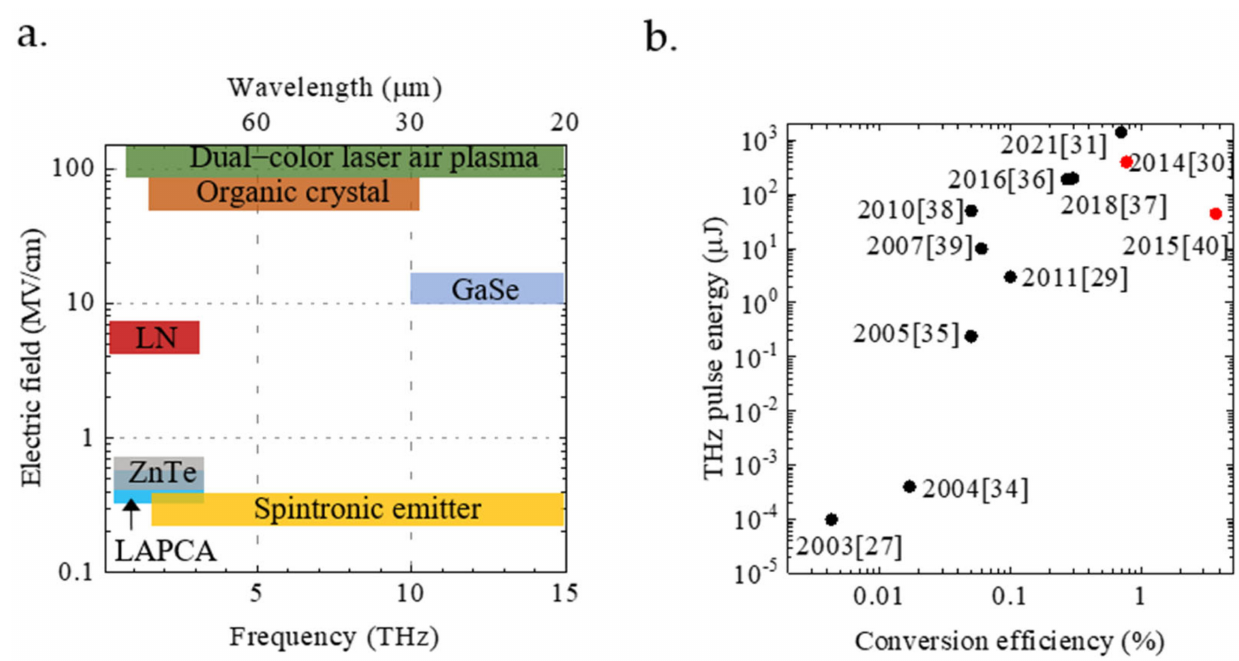
Figure 1. ( a ) Methods to generate high-field THz. The peak field records and typical outputted spectrum are listed for different conventional methods. Dual-color laser air plasma: 100 MV/cm [23] for 1–20 THz; organic crystal: 83 MV/cm [21] for 1–10 THz; GaSe: 12 MV/cm [32] for 10–40 THz; spintronic emitter: 300 kV/cm [33] for 1–30 THz; LAPCA: 330 kV/cm for 0.1–3 THz; ZnTe: 570 kV/cm for 0.1–3 THz [20]; LN: 6.3 MV/cm [31] for 0.1–3 THz. ( b ) Development of THz generation from LN with TPF techniques over the years [27,29–31,34–40]. The black dots represent 800 nm pump and the red dots represent 1030 nm